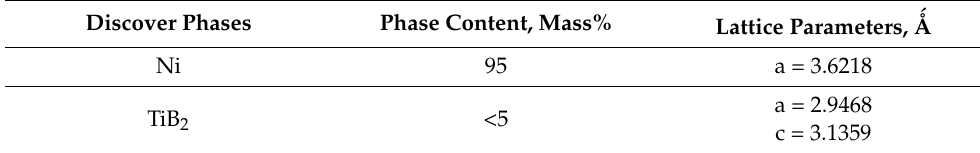
Table 3. Results of the X-ray diffraction analysis of the materials obtained by selective laser deposition